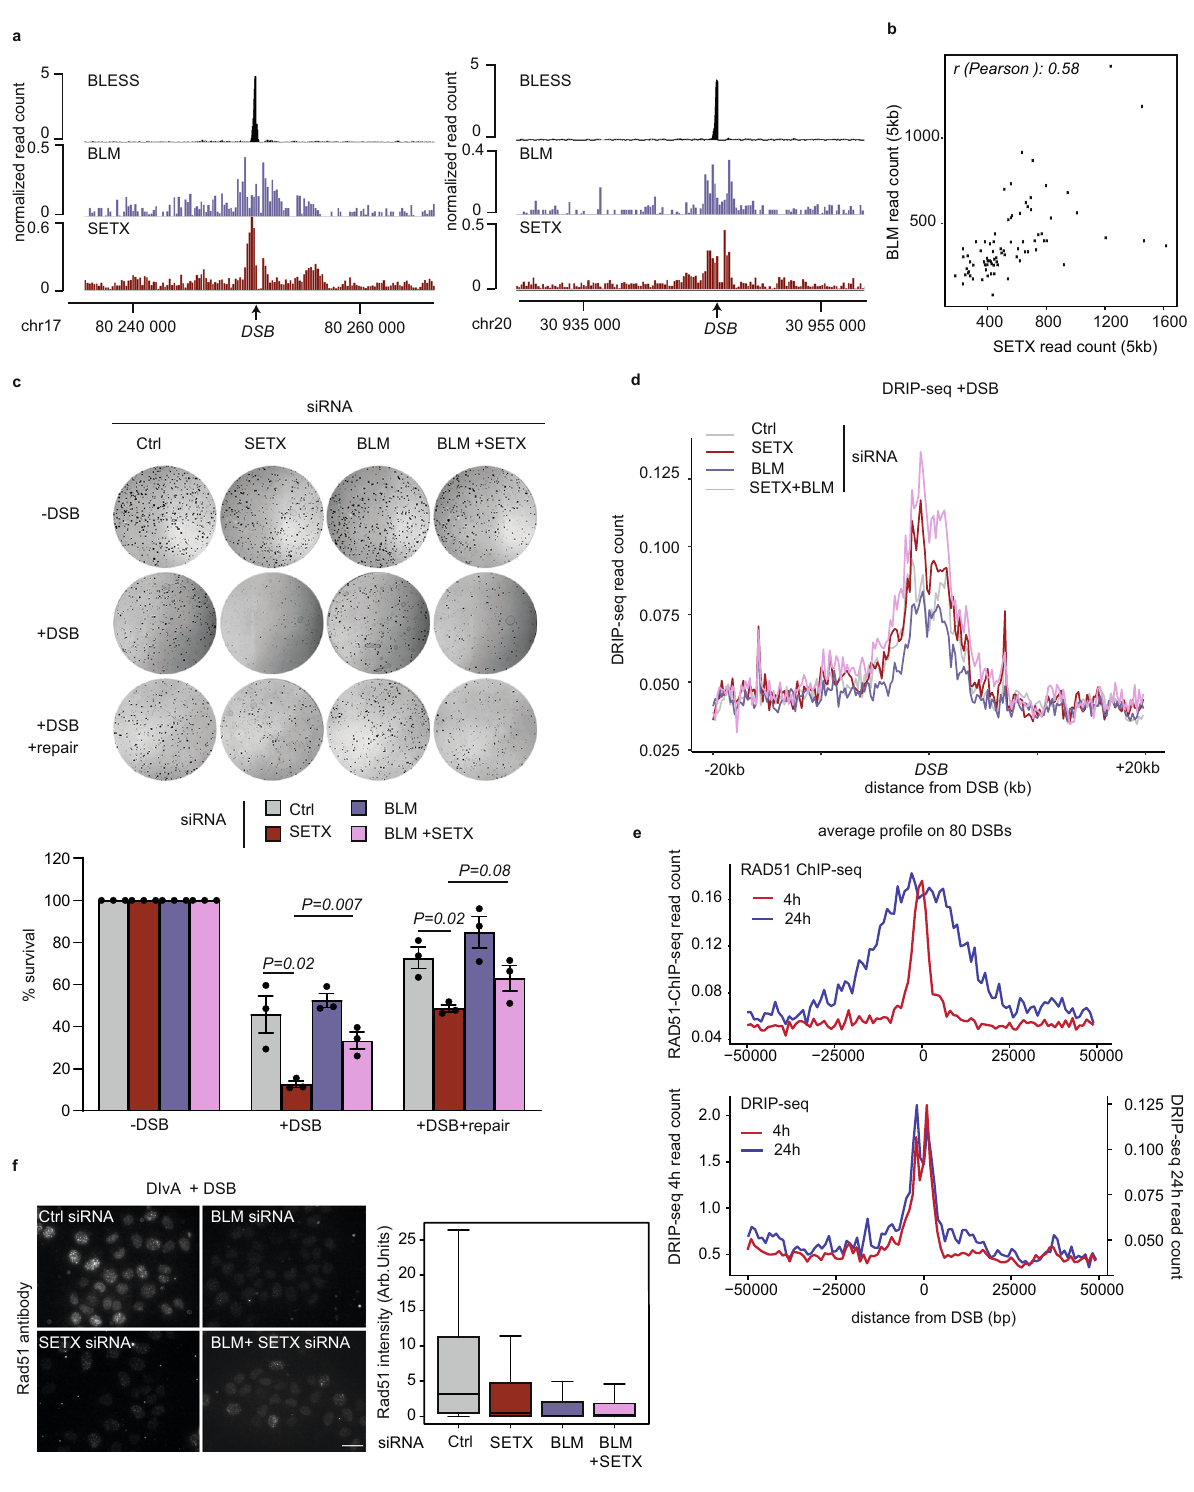
DSB-induced RNA:DNA hybrids, POLD3- and BLM-dependent DNA synthesis, takes place at DSBs, and contribute to the toxicity triggered by RNA:DNA hybrid accumulation at